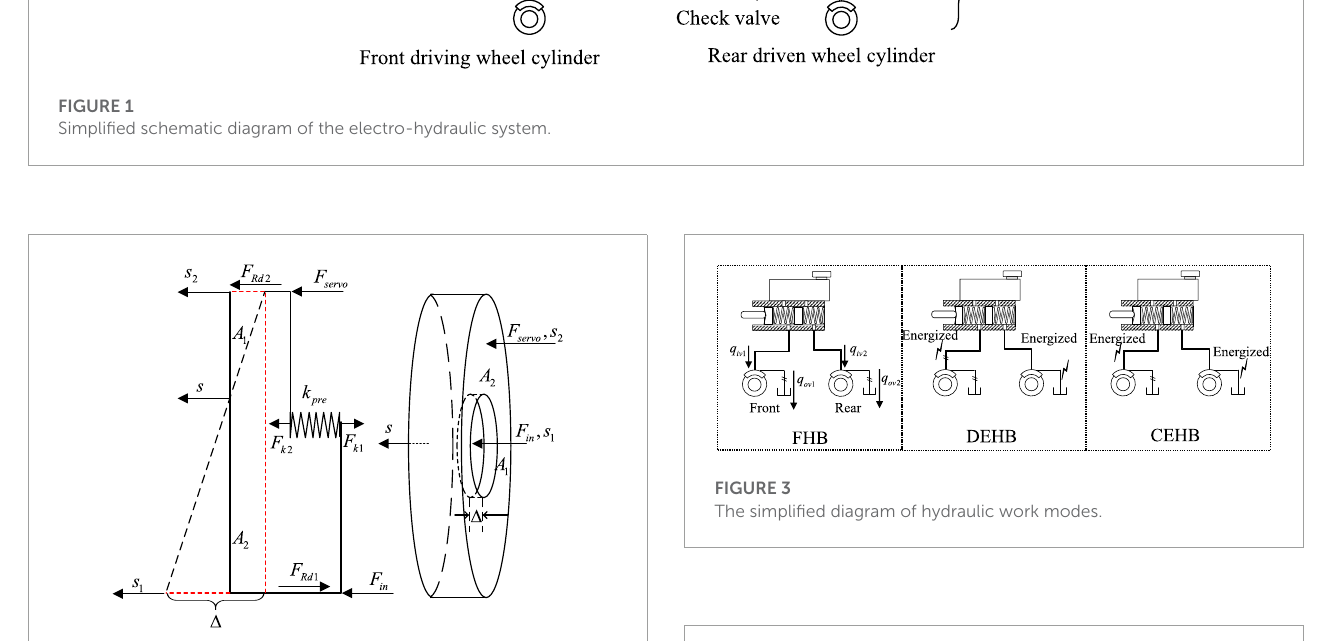
FIGURE 2 The diagram of the reaction disk.